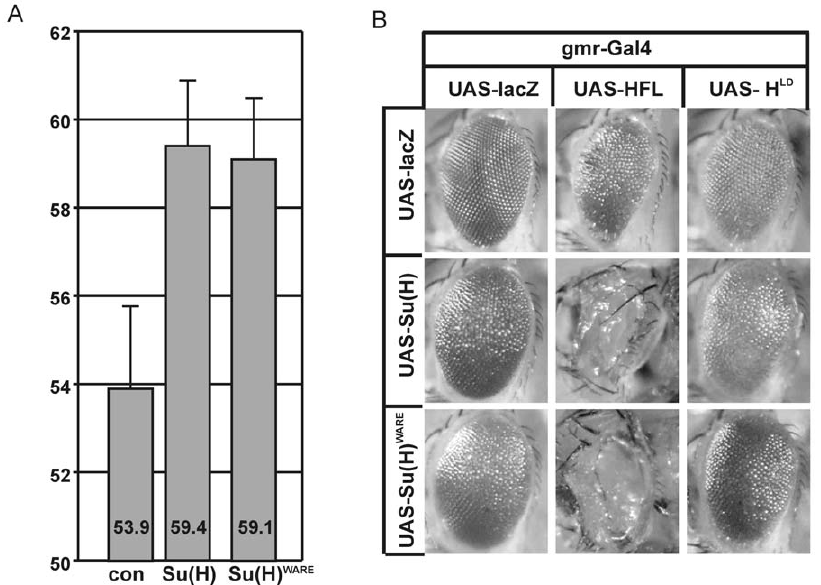
Figure 6. Overexpression of Su(H) und Hairless protein variants affect Drosophila eye development. A) Ectopic expression of Su(H) (lane 2) and Su(H) WARE (lane 3) cause an increase of eye size compared with a control lac-Z (con, lane 1) ectopic expression using the gmr-Gal4 driver line. Eye size of male flies was measured from 19 to 20 individuals of each genotype. Average area are given in kilo pixel (kpx). Error bar represents standard deviation. B) The UAS transgenes Su(H) and Su(H) WARE were expressed singly or in combination together with full length Hairless HFL or H LD , respectively, using gmr-Gal4 as driver line. As a control, lacZ was overexpressed which gives a wild type looking eye. Su(H) and Su(H) WARE induce a slight overgrowth of tissue resulting in enlarged eyes. In contrast, eye specific overexpression of HFL causes smaller eyes with irregular arrangement of the ommatidia, giving a rough appearance. Overexpression of H LD causes a nearly wild type eye. A combination of Su(H) with HFL results in a complete loss of the ommatidia: only a small eye slit remains that is totally smooth and devoid of any red eye pigment. In contrast a combined overexpression of Su(H) and H LD causes enlarged eyes similar to the sole Su(H) overexpression, demonstrating lack of protein binding. Overexpression of Su(H) WARE alone or in combination with Hairless variants gives similar results suggesting again that the WARE mutation does not influence repressor complex formation.